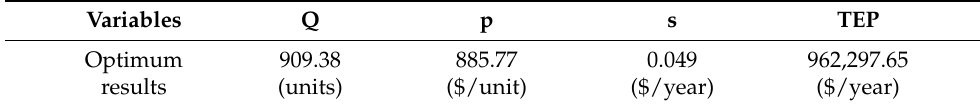
Table 5. Optimum outputs for the case of constant production rate.